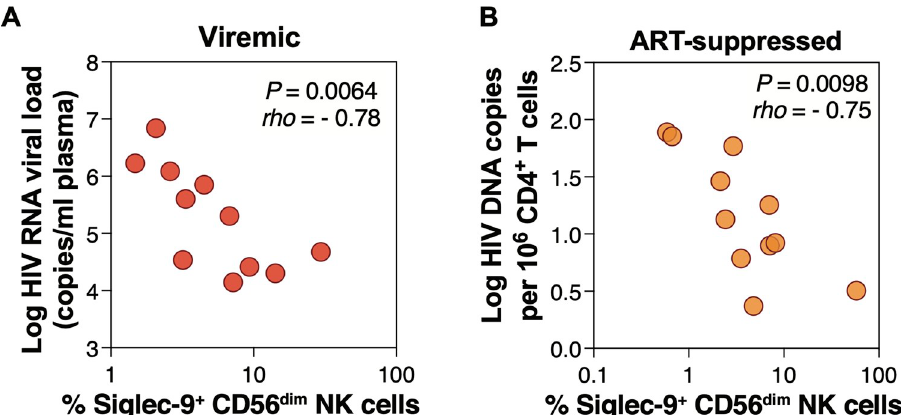
frequency of Siglec-9 + CD56 dim NK cells and HIV plasma viral load during viremic HIV infection. n = 11. (D) Spearman correlation between the frequency of Siglec-9 + CD56 dim NK cells and cell-associated HIV DNA copies per million CD4 + T cells during ART-suppressed HIV infection. n =